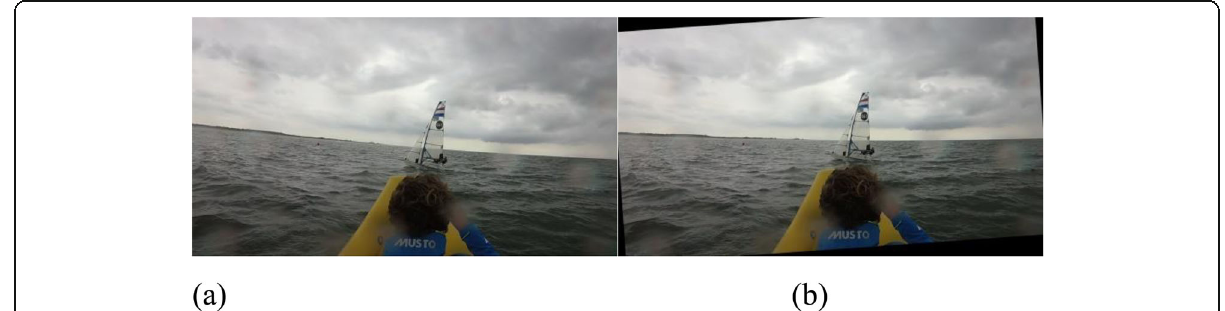
Fig. 4 Example transformation of a video frame. a : Raw frame extracted from the video; b : Result after applying